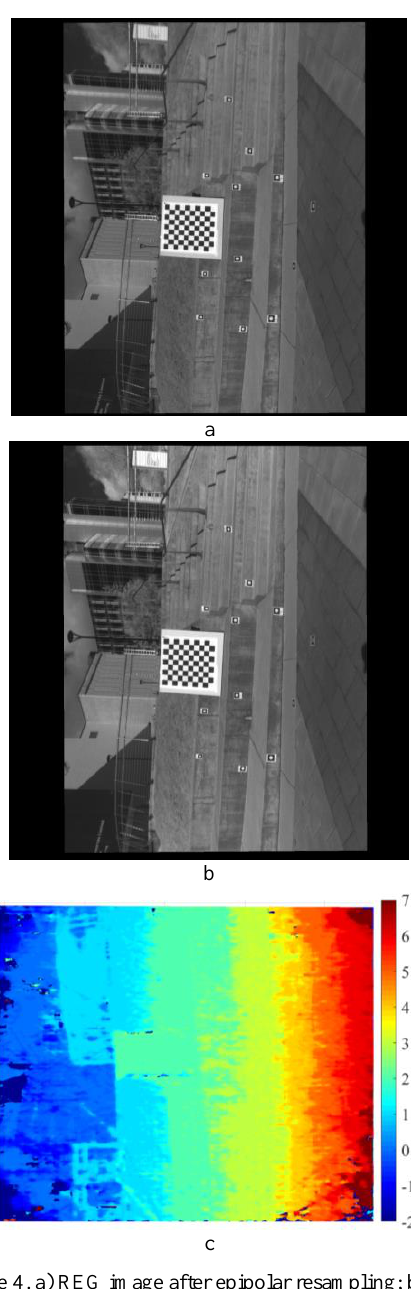
Figure 4. a) REG image after epipolar resampling; b) NIR image after epipolar resampling; c) disparity map (unit: pixels)